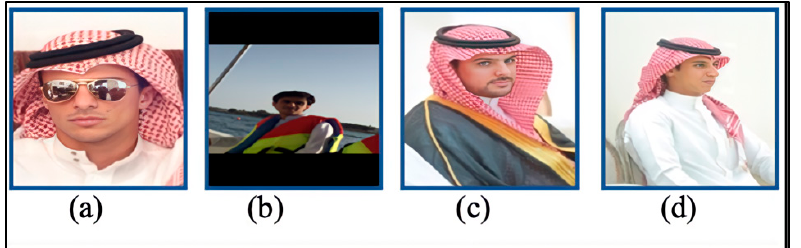
Figure 20. Samples of success recognized in different shape: ( a ) represents wearing sunglasses, while ( b ) represents so far shap and ( c , d ) represent half of the face is shown.